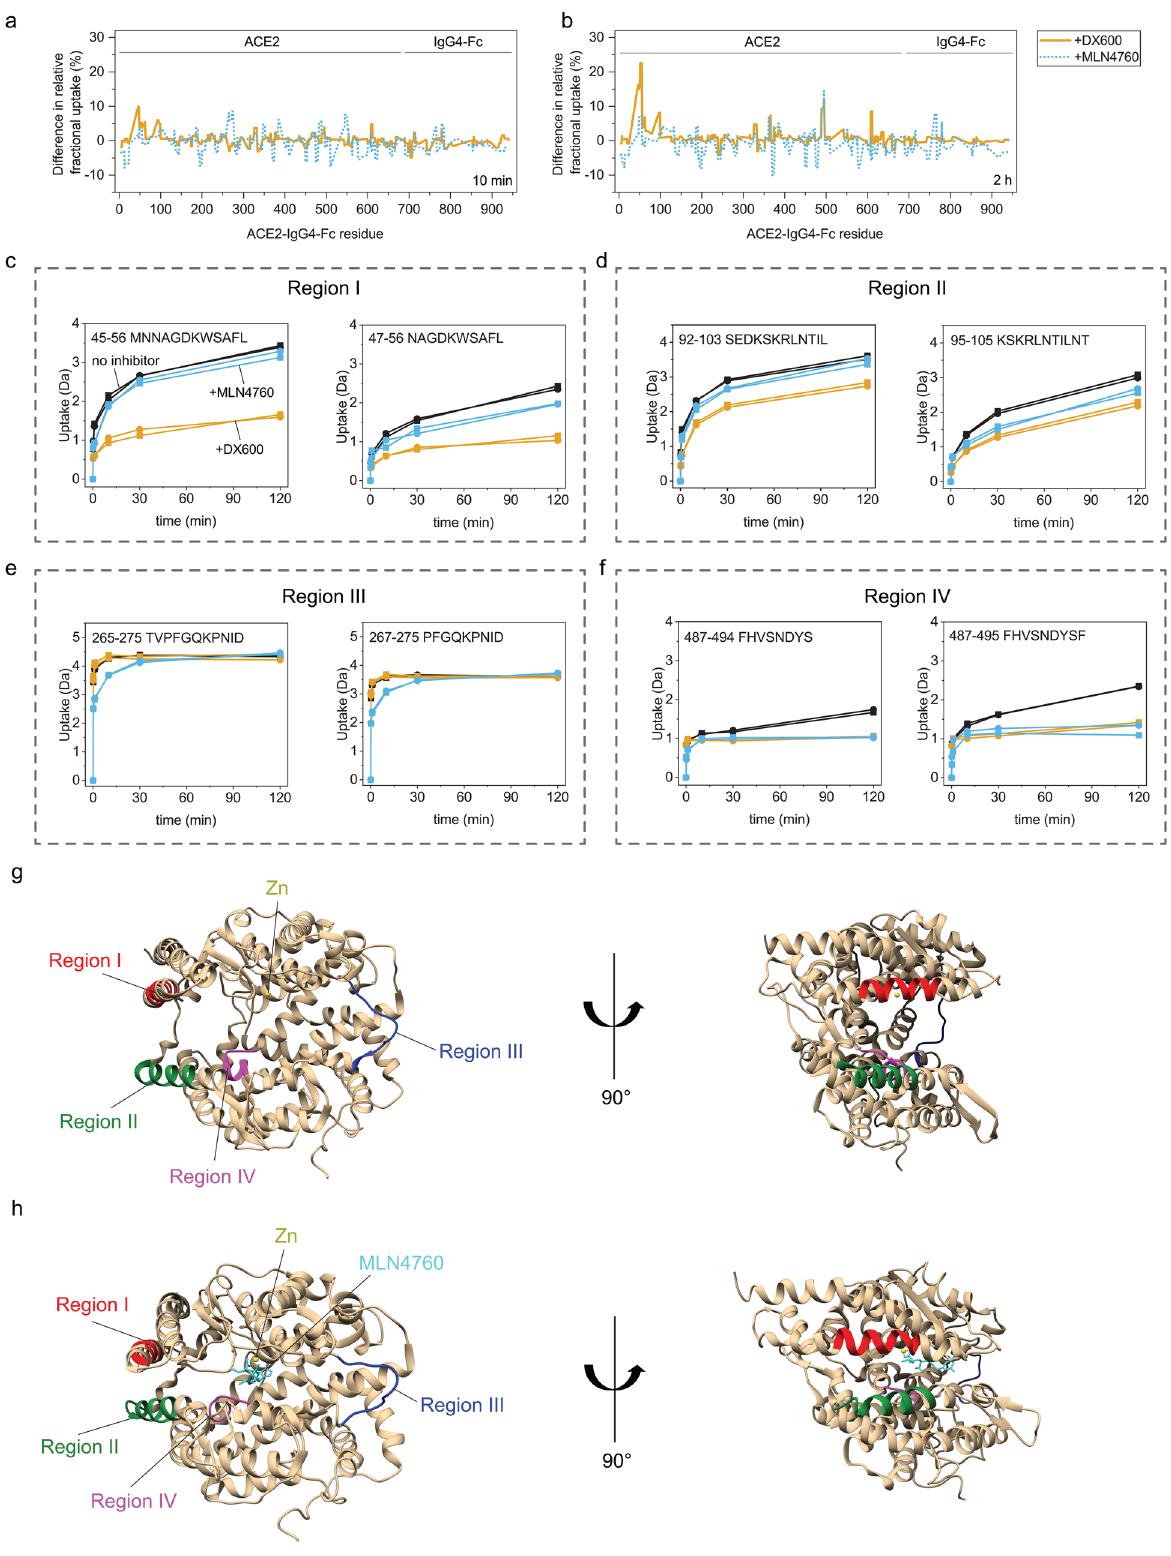
Fig. 5 Changes in the structural dynamics of ACE2-IgG4-Fc caused by the inhibitors. Difference in the relative fractional uptake from HDX measurements obtained at ( a ) 10 min and ( b ) 2 h exchange times. The plots show differences in the relative fractional uptake of ACE2-Fc without an inhibitor minus the relative fractional uptake of inhibitor-bound ACE2-Fc. ( c – f ) Deuterium uptake plots for the peptides in four identi fi ed regions. Crystal structure of ( g ) inhibitor-free ACE2 (PDB: 1R42) and ( h ) the ACE2 bound to MLN4760 (PDB: 1R4L) with annotations of the regions identi fi ed by